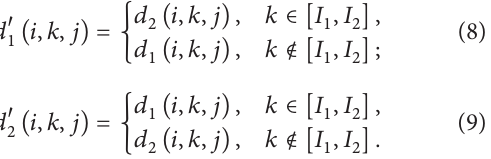
(𝑗) into (1) produces the 𝑖